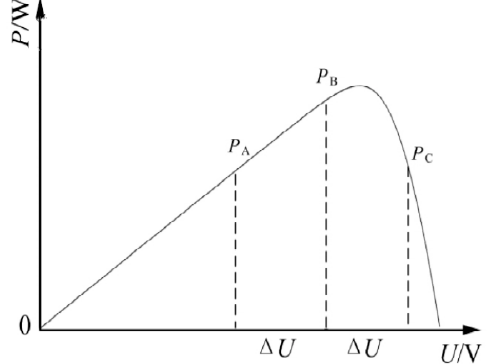
Figure 11. Analysis diagram of oscillation phenomenon.